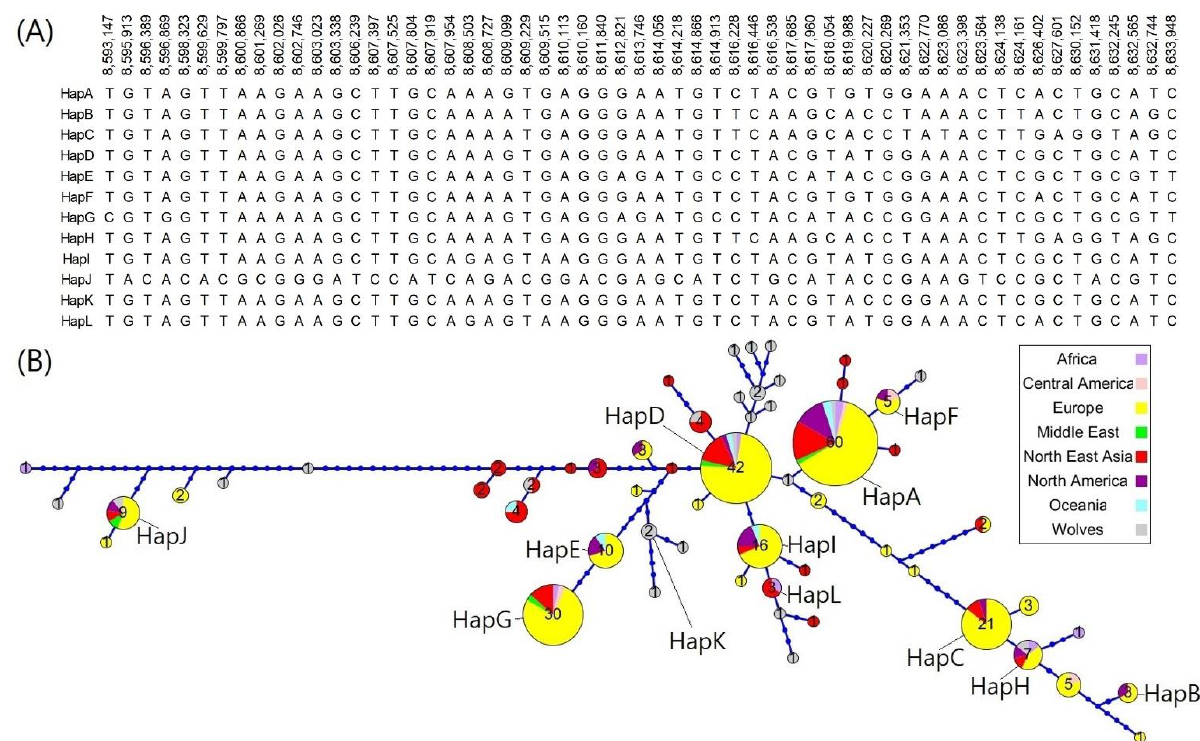
Figure 6. Haplotype tree showing the relationships of the 58 haplotypes belonging to the haplotype block 20 of the RSPO2 3' UTR-linked region on dog chromosome 13. The 12 major haplotypes (HapA to L) with frequencies >0.01 are shown with the corresponding SNPs and chromosomal coordinates in ( A ) and indicated within or next to each haplotype node in the haplotype tree ( B ). Haplotype nodes are colored differently according to the geological origin of the breed, and the number of breeds with the corresponding haplotype is specified at each node. The distance between the nodes was determined based on nucleotide differences among haplotype sequences, and each node represents a difference of 1 SNP from the adjacent nodes or dots. Blue dots indicate intermediate sequence states between two different haplotype node